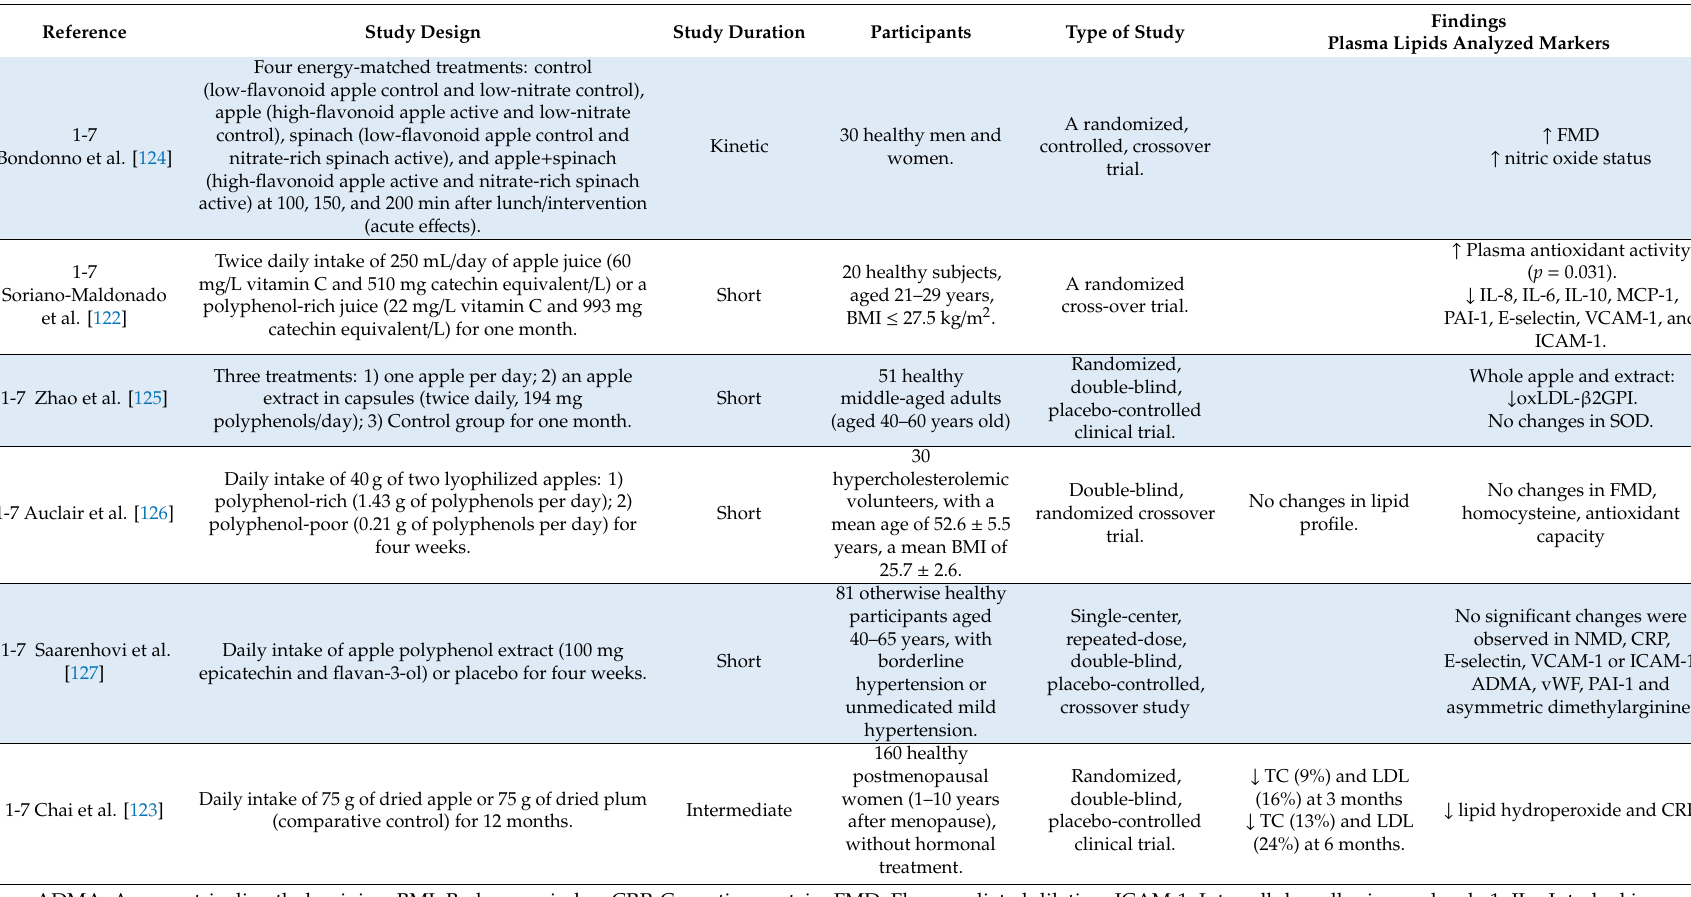
Table 4. Potential protective e ff ect of apples or their bioactive compounds on proinflammatory and oxidative stress markers during the progression of